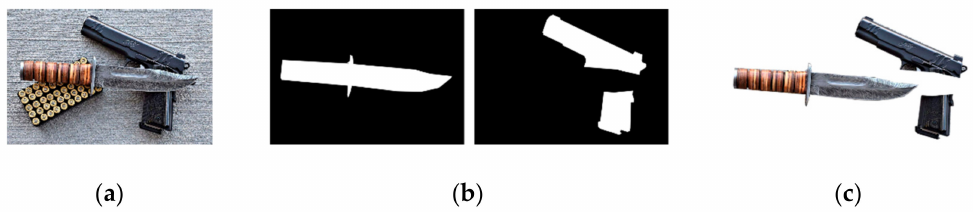
Figure 1. Instance segmentation. ( a ) Input image. ( b ) Binary masks for each target object. ( c ) Isolated objects using the binary masks (for visualization).